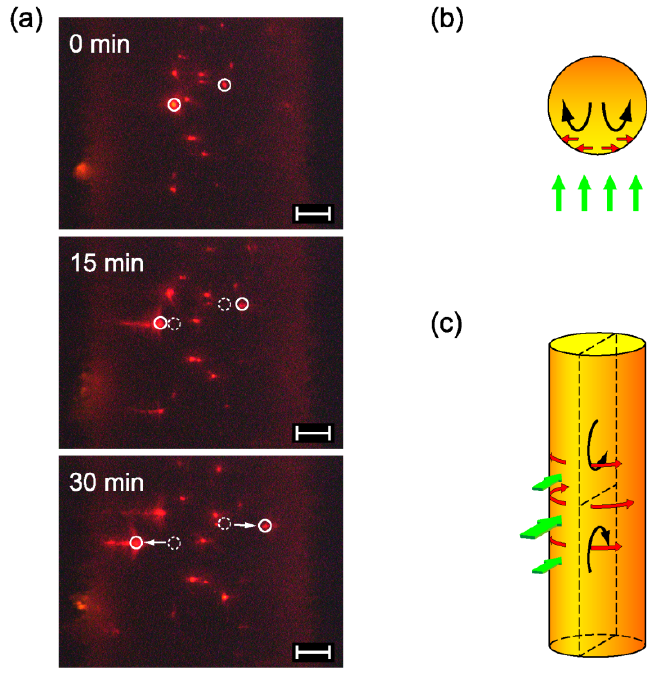
Figure 5. ( a ) Photographs of fluorescence patterns of QDs-doped BFlAB fiber upon irradiation using V-polarized laser beam viewed from the back of the irradiated surface. Scale bar: 10 µm. ( b , c ) Schematic illustration for plausible mechanism of the bending motion in the negative direction upon V-polarized laser beam. See